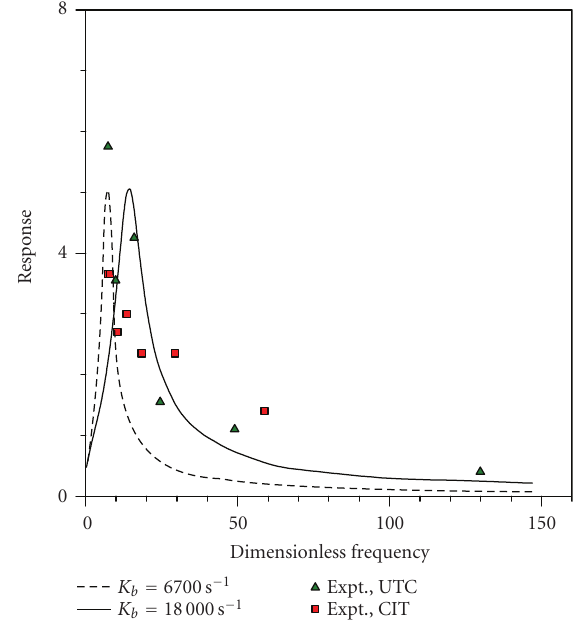
Figure 8: Frequency response of AP/PBAN Propellant C, the- ory ( K b = 6700 s − 1 , Δ H s = 115000 J/kg; K b = 18000 s − 1 , Δ H s = 68000 J/kg) and experiment [24, 26], in terms of real part of pressure-based function (theory & experiment, pressure at 300